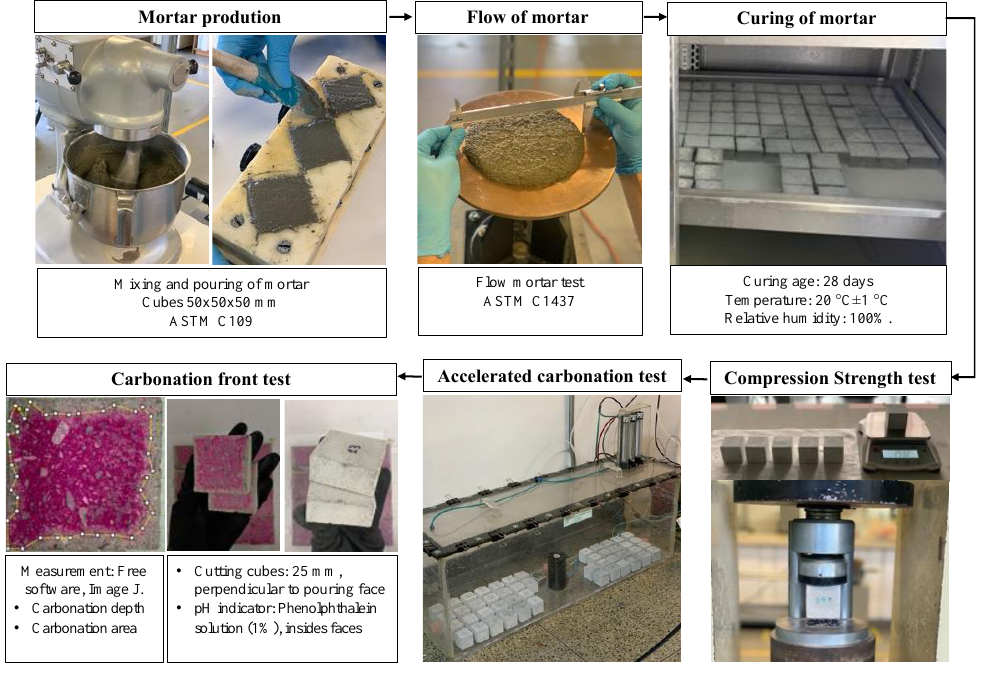
Figure 5. Mortar production and evaluation.